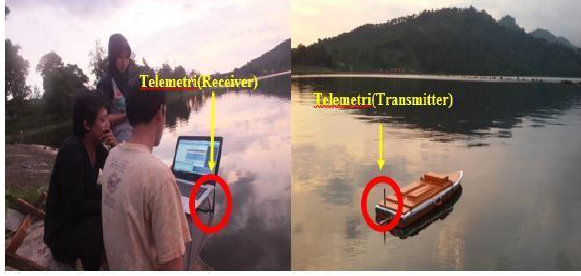
Figure 8. Receivers for ROV boat and laptop (data download)